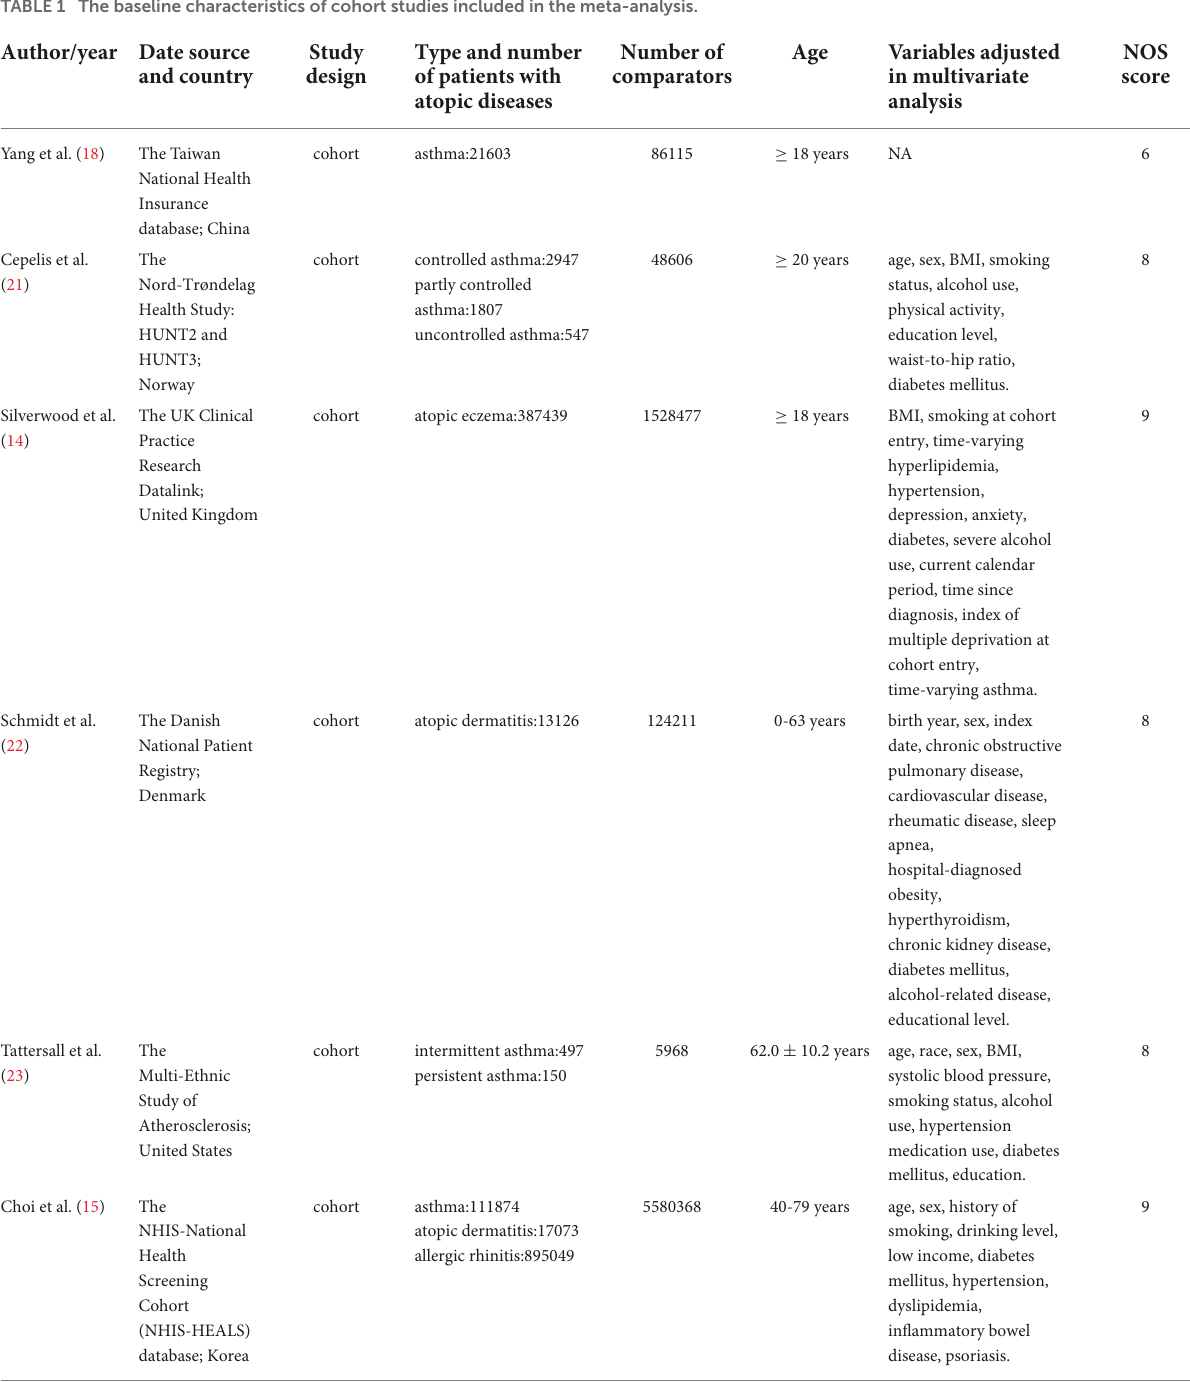
TABLE 1 The baseline characteristics of cohort studies included in the